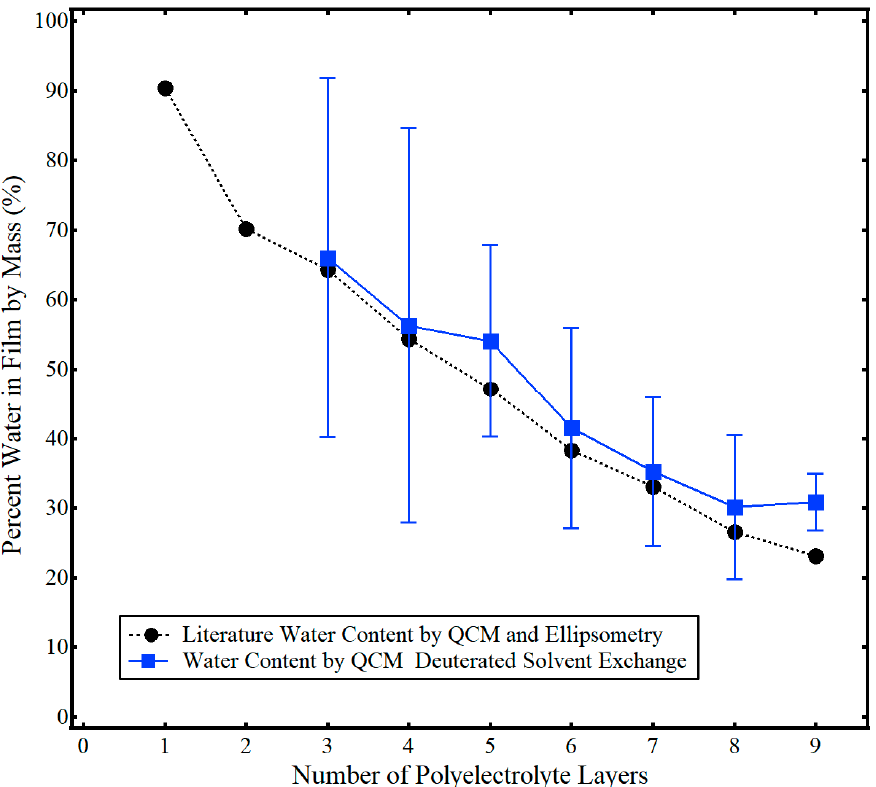
Figure 4. Percent water in PAH/PSS polyelectrolyte films as a function of the number of polyelec- trolyte layers determined by QCM-D deuterated solvent exchange in this work ( ■ ) and results from Iturri Ramos et al. using QCM and ellipsometry ( ● ) [14]. Error bars indicate one standard deviation from the mean. Adapted from Jagoba J. Iturri Ramos, Stefan Stahl, Ralf P. Richter, and Sergio E. Moya Macromolecules 2010 43 (21), 9063–9070. Copyright 2010 American Chemical Soci- ety.